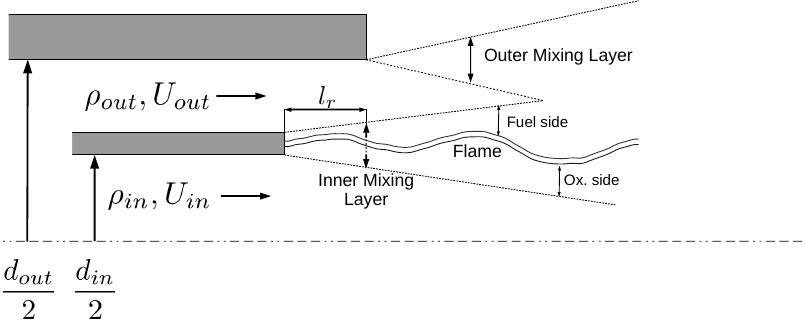
Figure 1. Schematic of a coaxial-jet structure for a recessed injector with recess length l r . Inner and outer mixing-layers are formed between the central and annular flow, and the annular and external environment,